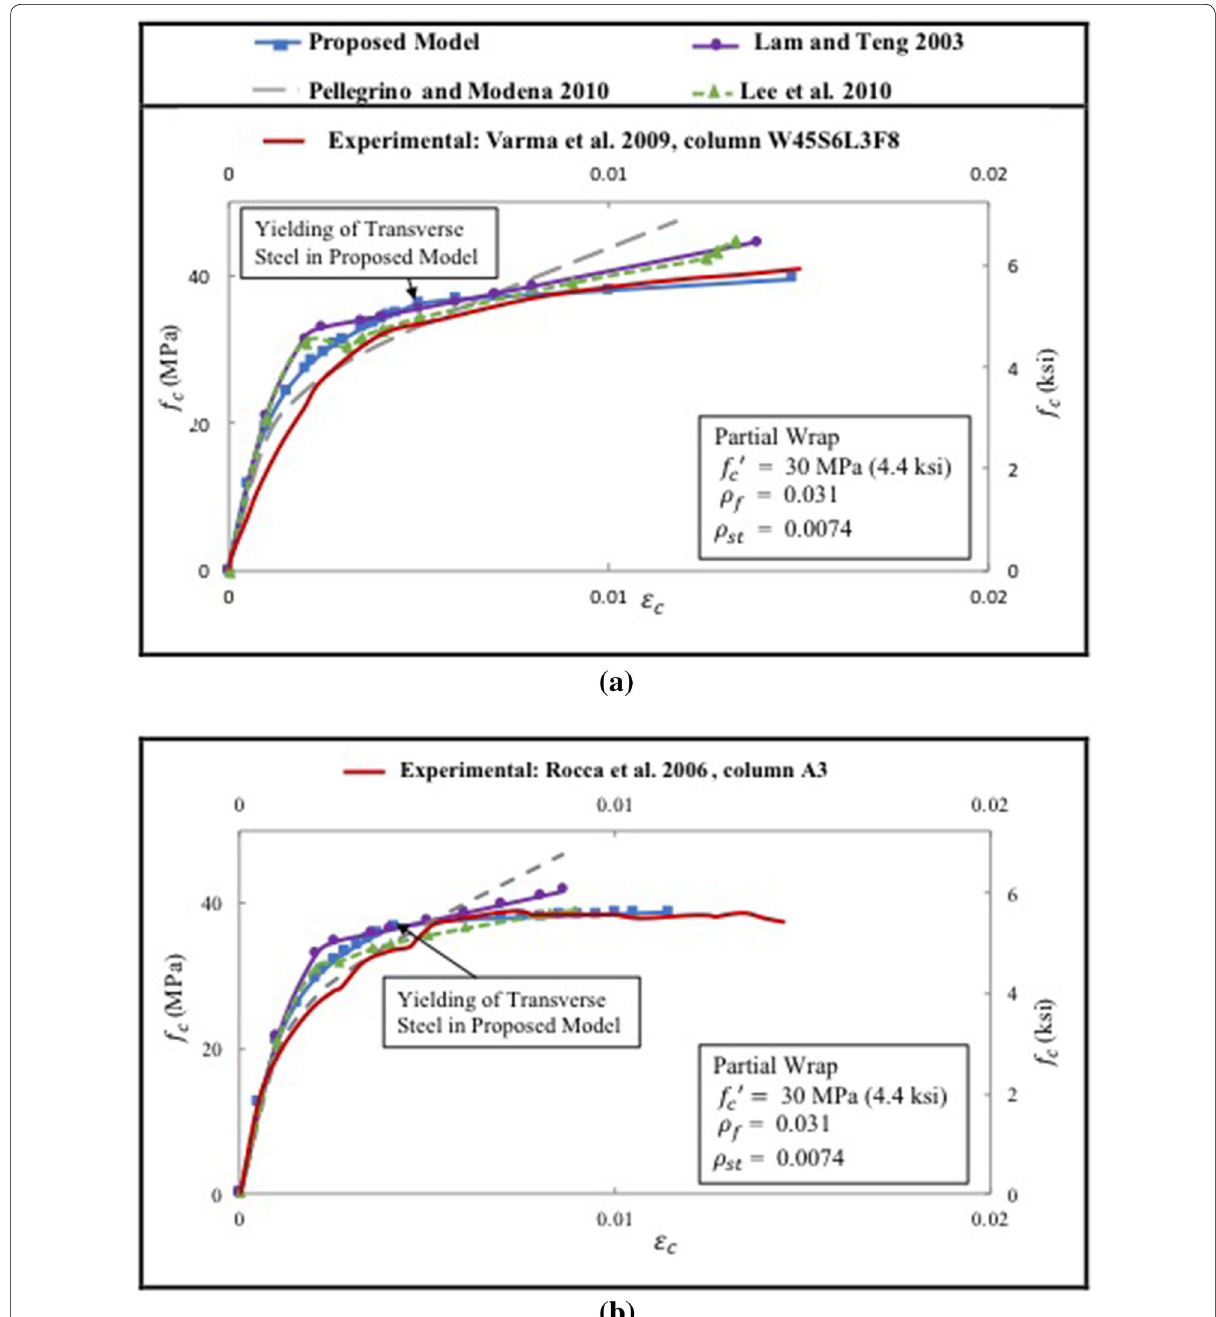
Fig. 12 Comparison between the proposed model and experimental compressive stress ( f c ) versus axial strain (ε c ) for partially wrapped circular RC